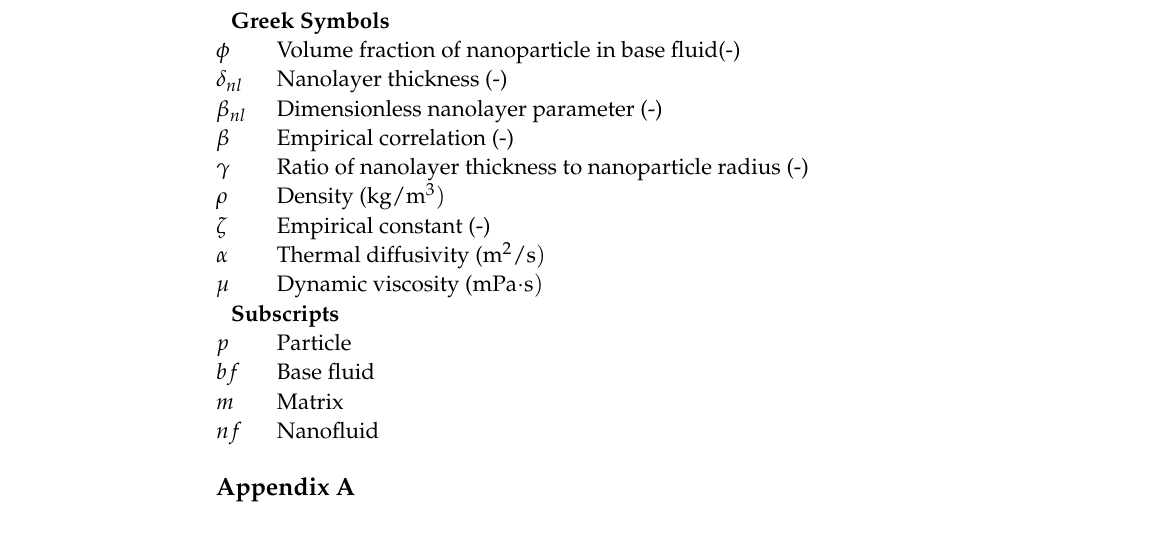
Table A1. Summary of existing experimental